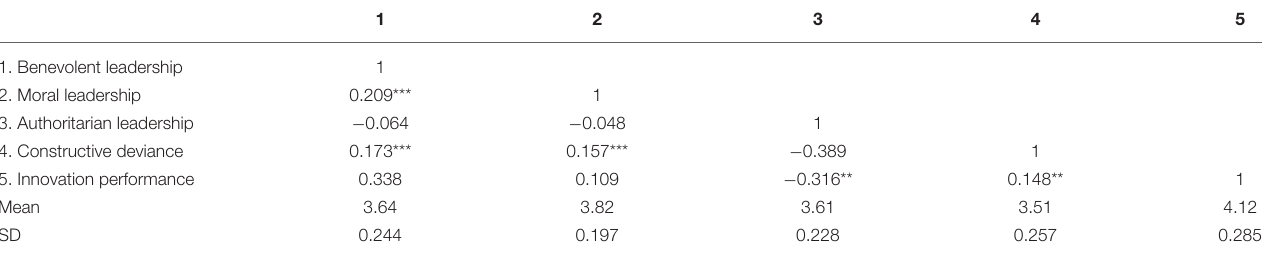
TABLE 2 | Correlation analysis.